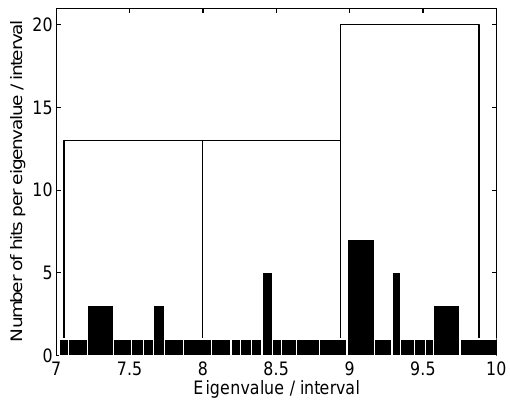
Figure 1. Number of hits of the nonlinear Arnoldi method with local restarts for the interval (7 , 10) per eigenvalue and interval, respectively.